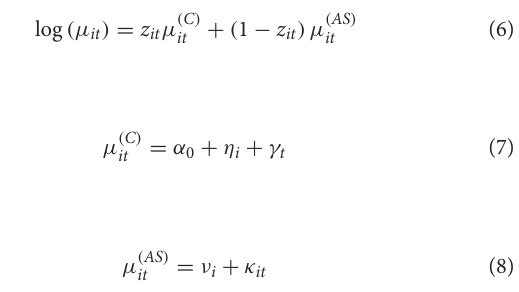
and the Bayesian mixture model for HB risk